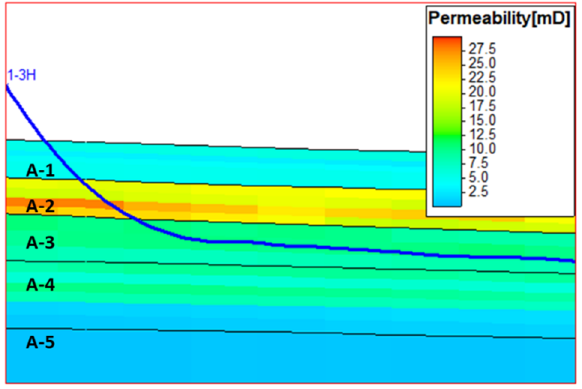
Figure 10. Well trajectory of abnormal linear flow slope well.